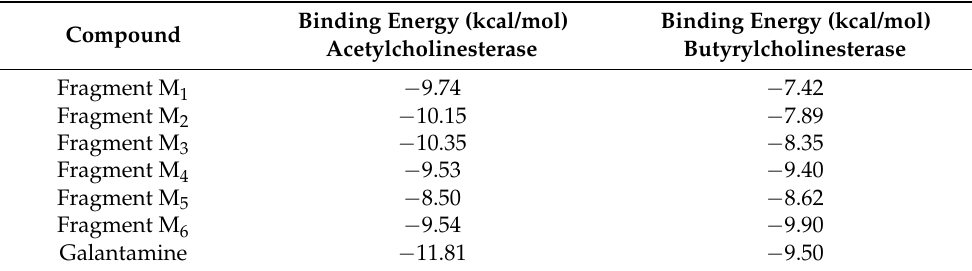
Table 4. Binding energies obtained from docking experiments of carotenoids in haloarchaea species over acetylcholinesterase and